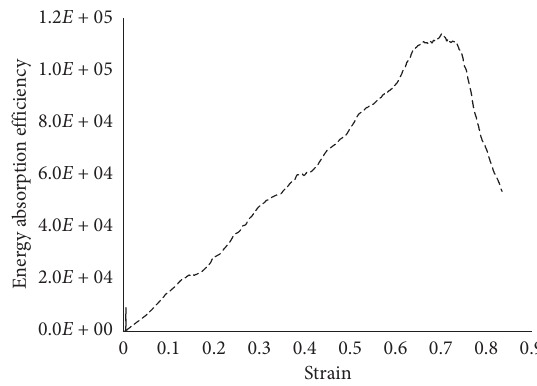
Figure 6: Energy absorption efficiency-strain curve of honeycomb aluminum in out-of-plane quasi-static compressive load case.